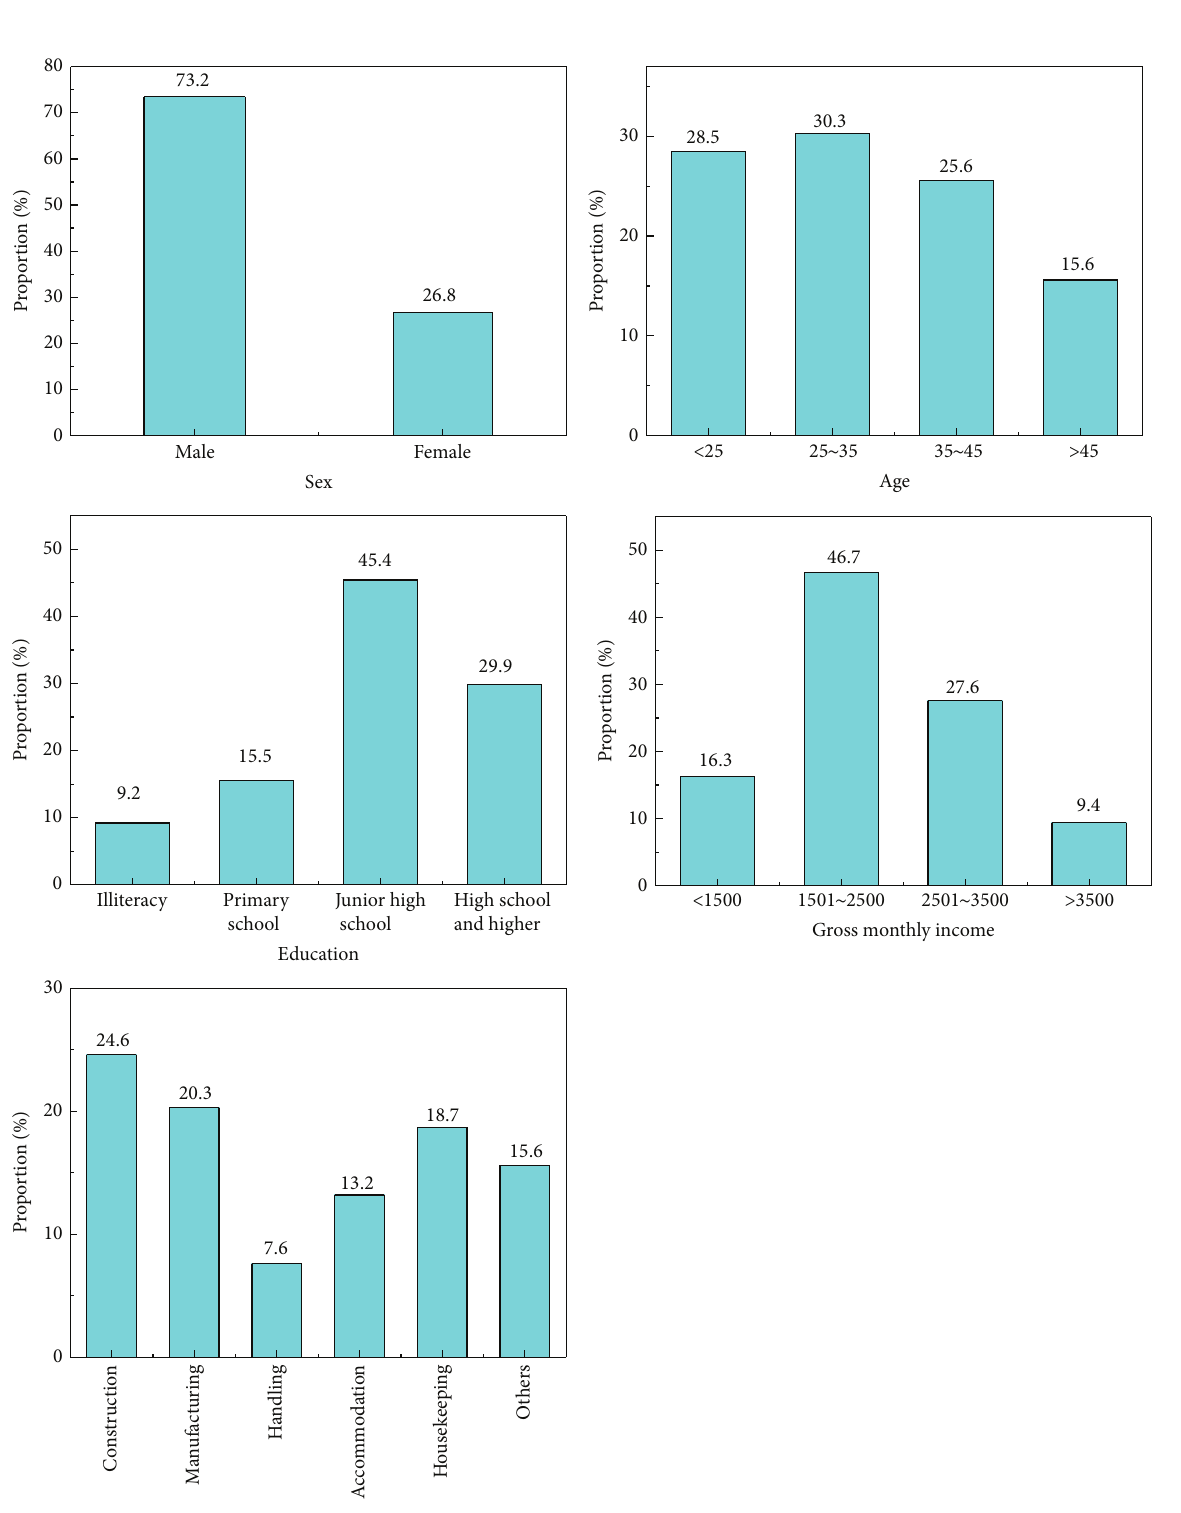
Figure 2: Individual attribute data of migrant